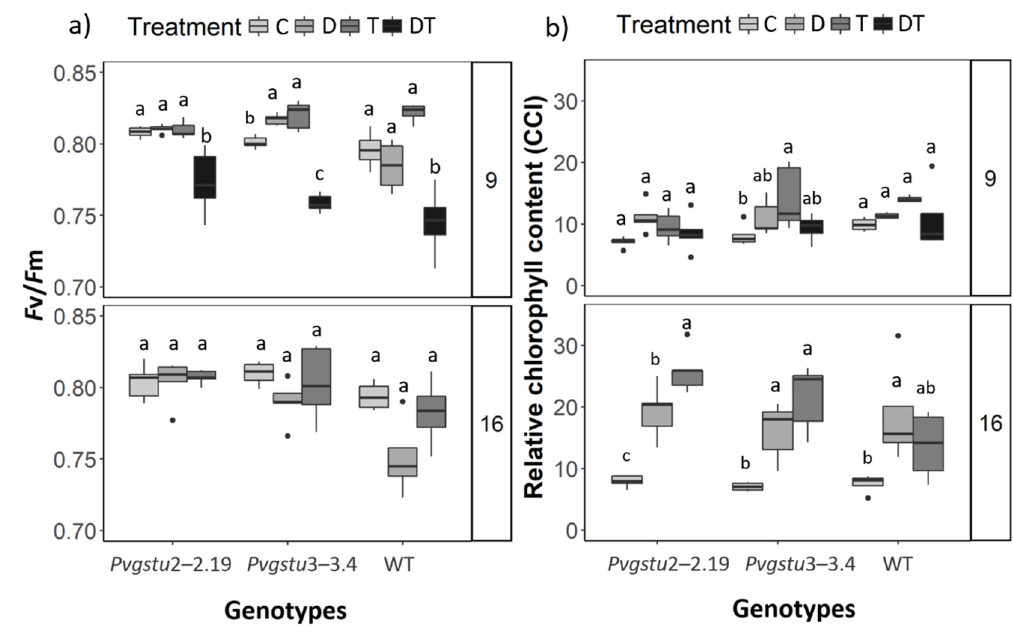
Figure 3. Physiological measurements: ( a ) maximum fluorescence ( F v/ F m) of photosystem II and ( b ) relative chlorophyll content (CCI) measured in the transgenic lines Pvgstu3–3.4 and Pvgstu2–2.19 and WT plants growing under control (C), drought (D), heat (T) and combination of drought and heat stresses (DT), at nine and 16 days. Different letters indicate significant differences among treatments for each genotype at p < 0.05. Data are means ± SE (WT: n = 4; Pvgstu lines at 9 days: n = 5; at 16 days: n = 7).